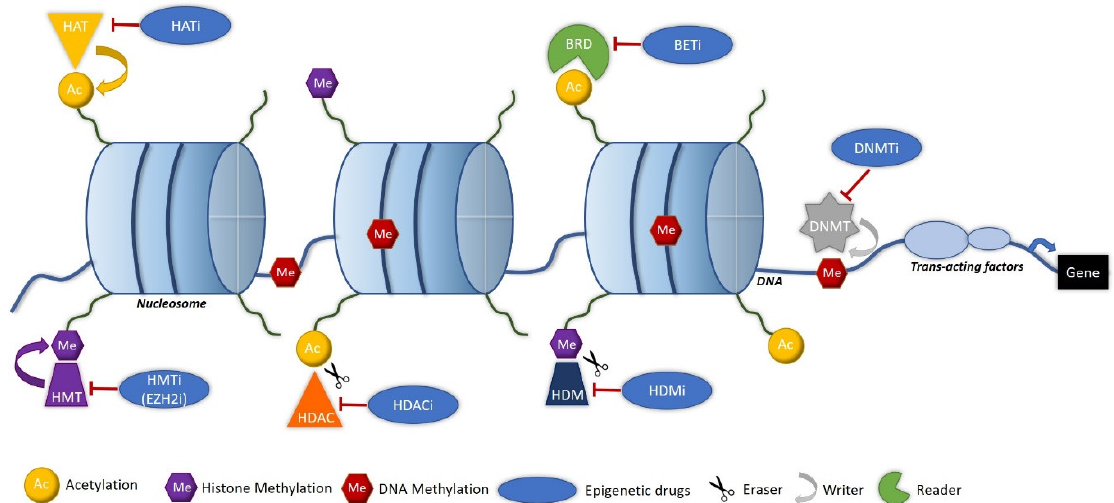
Figure 4. Targets of the epigenetic drugs. BETi = bromodomain and extra-terminal domain proteins inhibitors, BRD = bromodomain, DNMT = DNA methyltransferase, DNMTi = DNA methyltransferase